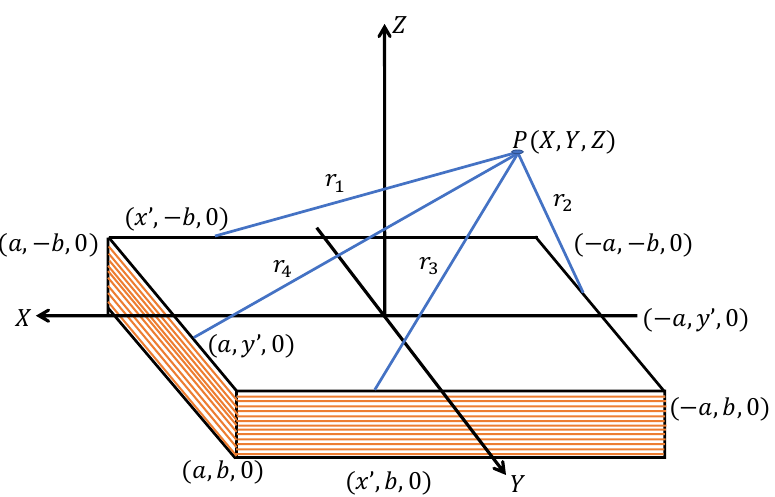
Figure 1. Square magnetic coil and point of interest to analyze.